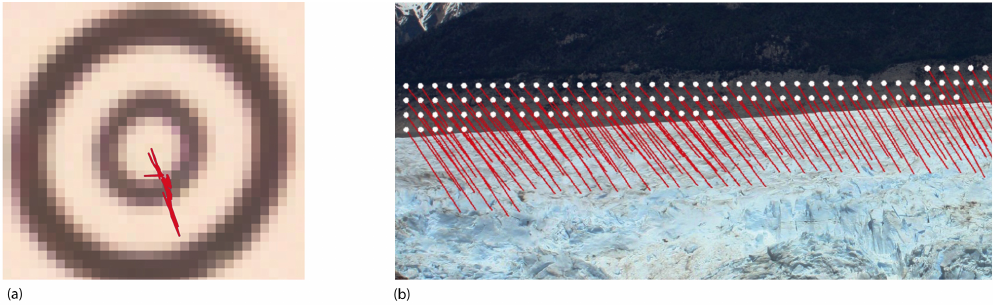
Figure 9. Tracking of static fiducial marks and/or static natural points. In panel (a) , the figure shows an example of a signalized static point as it is visible in a sequence image. The red line here shows the motion path of the mark during a 24h image sequence (acquisition interval 20min). In panel (b) , an example of the use of natural static points is shown. The white dots represent a raster of static points that have been defined on the mountain slope in the background of the glacier. The red vectors (enlarged) represent the results for tracking these points from one sequence image into another one recorded 24h later. The red motion lines of the static points (signalized or natural) correspond to the effect of camera